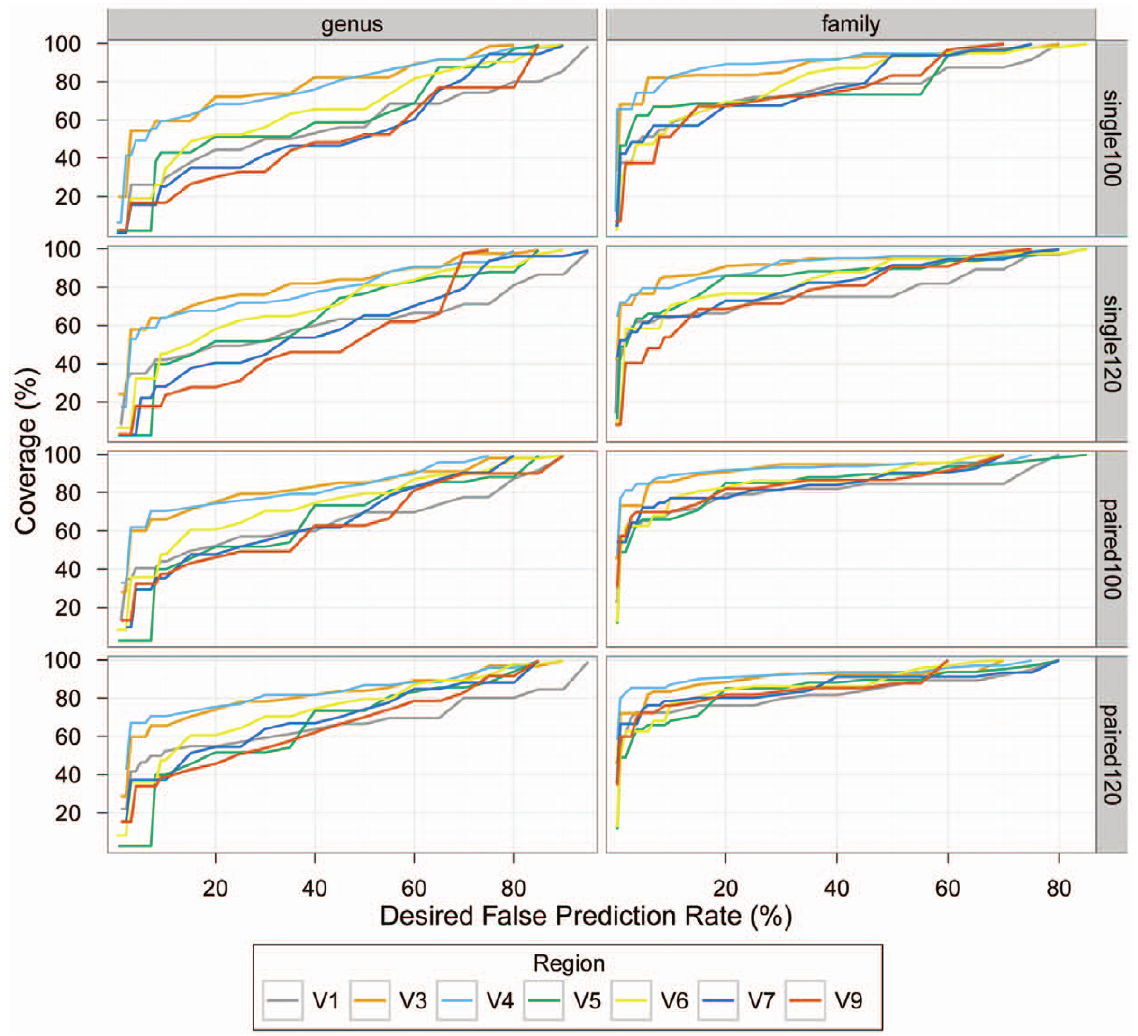
Figure 2. Classification performance of different experimental designs. Each panel compares performance of different regions for a different combination of rank (genus or family) and sequencing strategy (100/120 nt single/paired-end reads). We used the results of leave-k-out tests classifying the LTP sequences to determine confidence score thresholds for a set of desired false prediction rate (FPR) values (x axis), so that the FPR would be at most the desired value (Tables S4, S5, S6, S7, S8, S9, and S10). We then used these thresholds to calculate the classification coverage of sequences from environmental (uncultured) bacteria that corresponds to the desired FPR (y axis). Figure S5 compares the performance of different regions across the same sequencing configurations for the ranks order, class, and